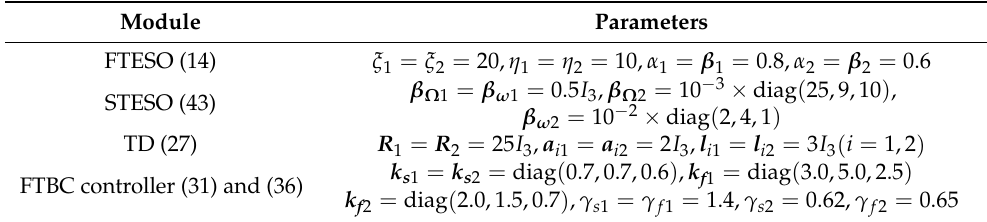
Table 1. FTBC Controller